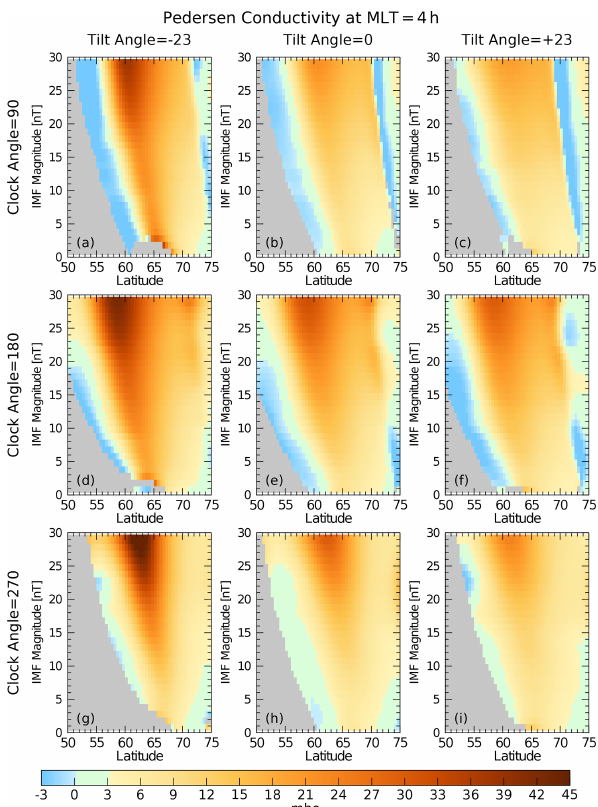
Figure 7. Hall conductivity as a function of latitude from 50 to 75 ◦ at 4:00MLT. The format of the graph is the same as in Fig.